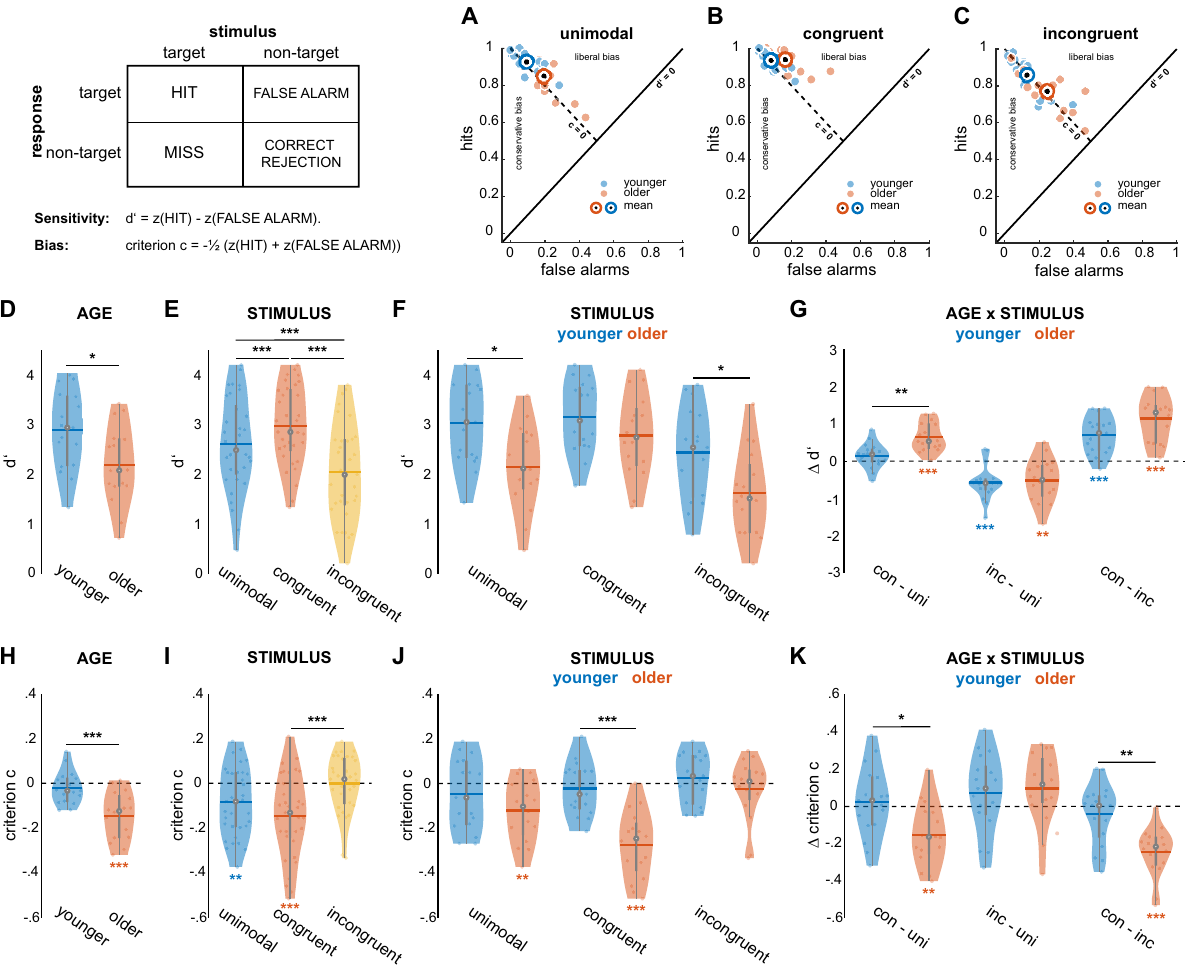
Figure 2. Age- and stimulus-related differences in sensitivity d ′ and bias c. Violin plots show mean value (horizontal line), median (white dot), interquartile range (horizontal line) and data of individual participants (coloured dots). Black asterisks indicate statistical significance of t-tests for pairwise comparisons, coloured asterisks indicate significance for one-sample t-tests against zero (* p < 0.05, ** p < 0.01, *** p < 0.001). ( A–C ) Hits and false alarms as a function of STIMULUS, separately for younger and older groups. ( D ) Effect of AGE on d ′ . ( E ) Effect of STIMULUS on d ′ . ( F ) and ( G ) Interaction between AGE and STIMULUS for d ′ scores is shown as difference between conditions of STIMULUS, separately for younger and older groups. ( H ) Effect of AGE on criterion c. ( I ) Effect of STIMULUS on criterion c. ( J ) and ( K ) Interaction between AGE and STIMULUS for criterion c. All conditions of STIMULUS are shown separately for younger and older